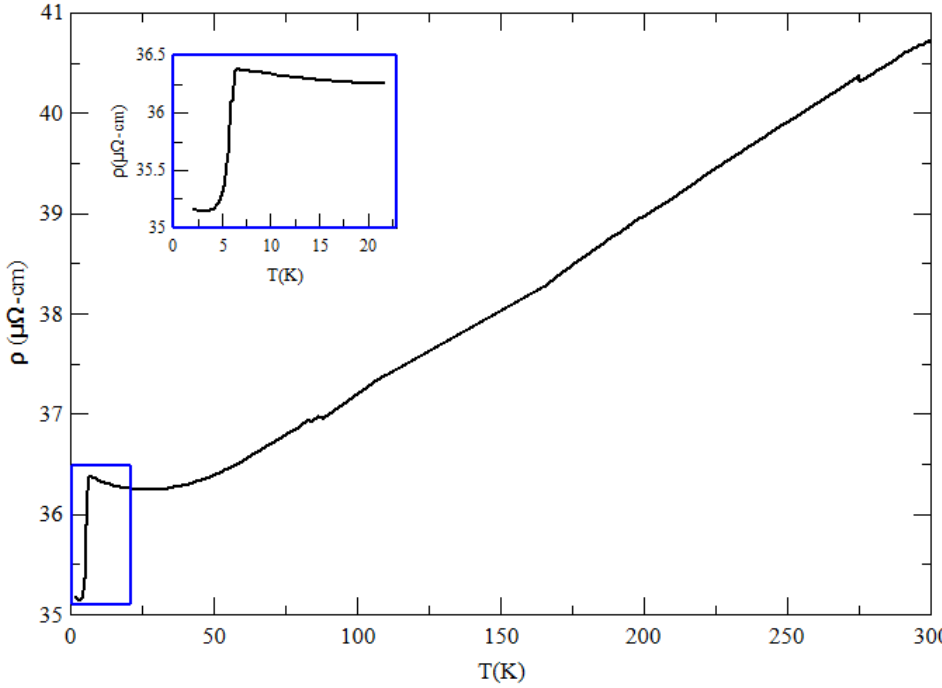
Figure 3. Resistivity versus temperature plot showing a metallic behavior of the MoP